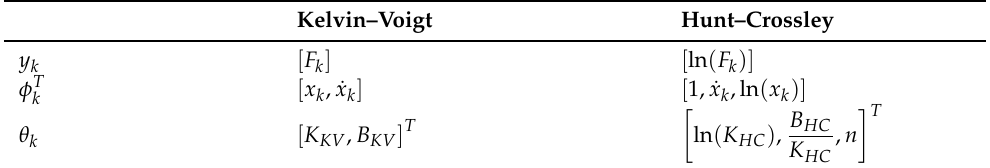
Table 1. Linearised Force Models Used in the EWRLS Algorithm. Kelvin–Voigt